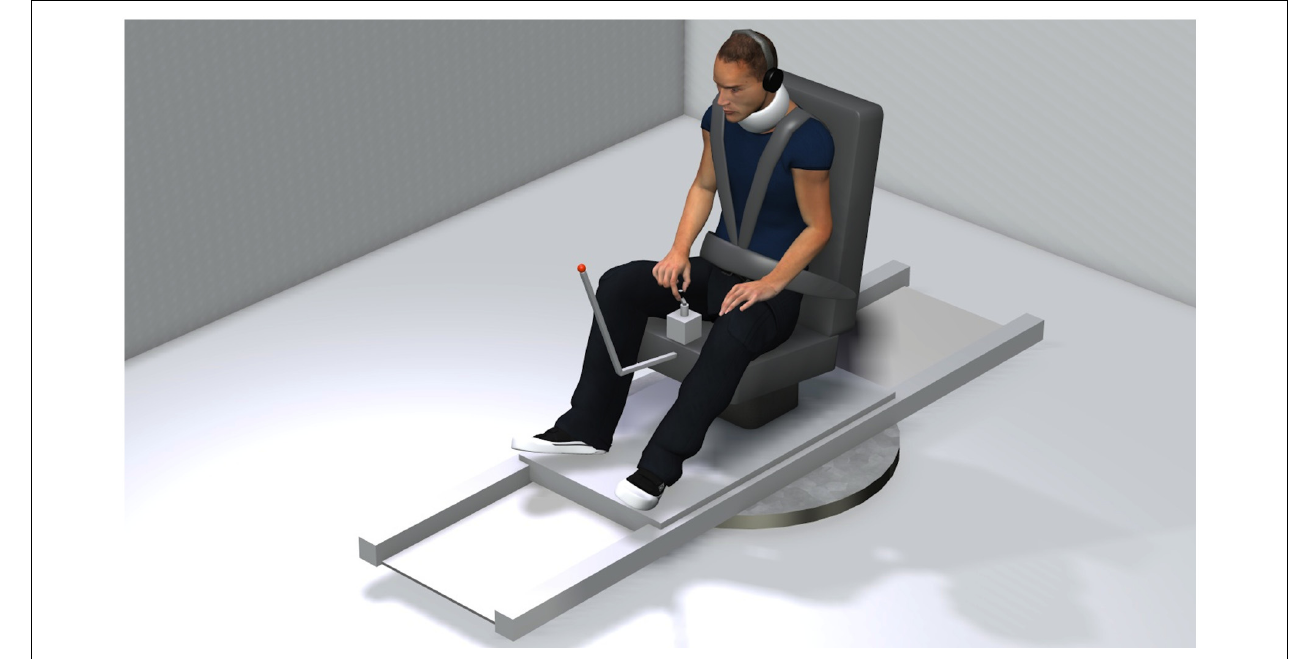
FIGURE 1 | Schematic representation of the experimental